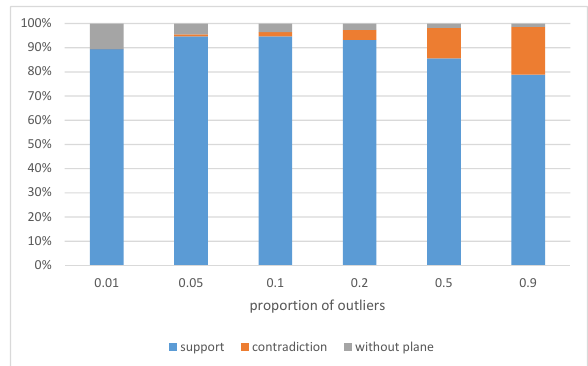
Figure 8. Proportion of the different point sets.